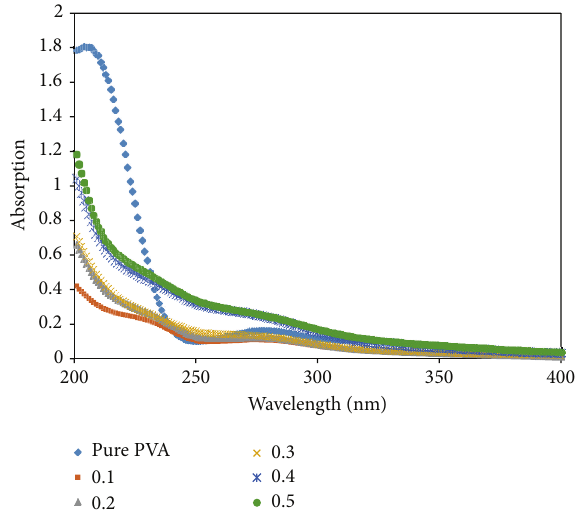
Figure 1: Absorption spectra for pure PVA and PPVA films at five PA: PVA mole